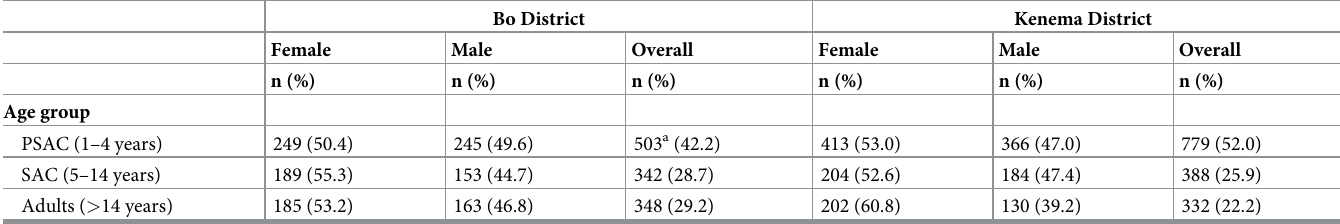
Table 1. Age and sex breakdown of respondents by